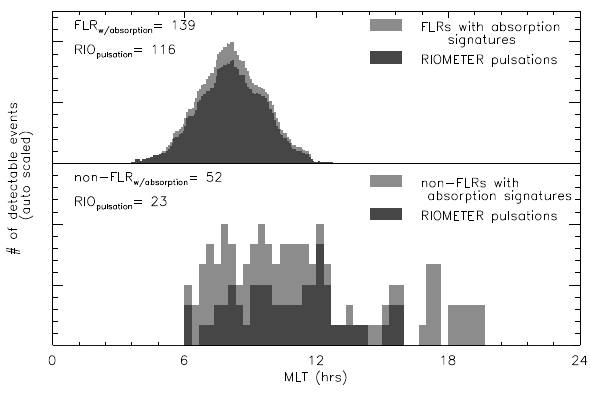
Fig. 9. MLT Occurrence of riometer pulsations corresponding to field line resonances from Baker et al. (2003) and non-field line